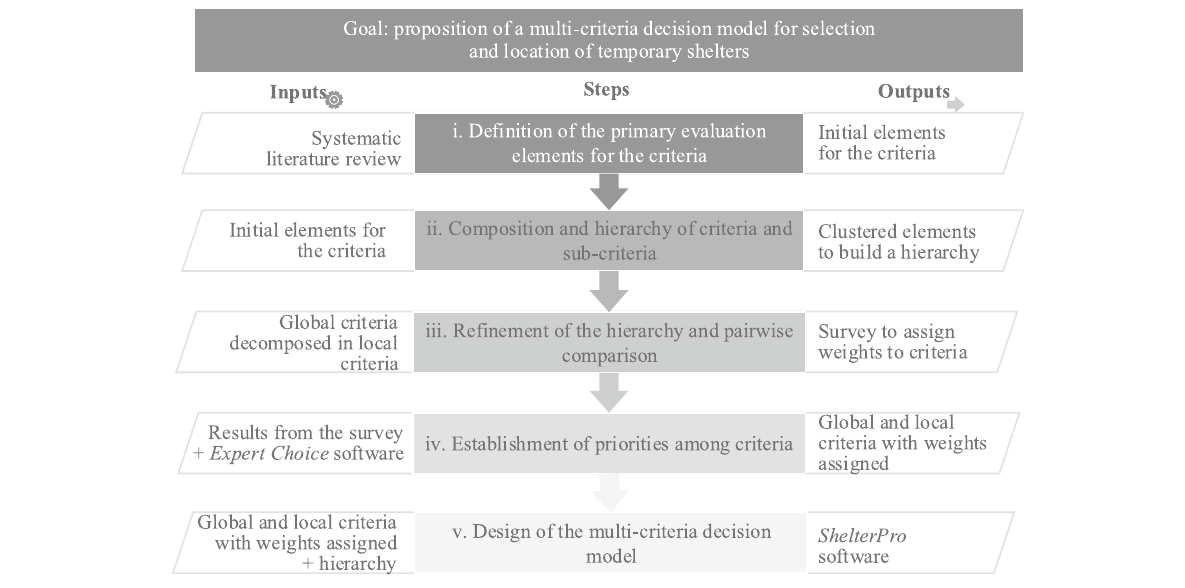
Fig. 1 Methodological steps to develop the multi-criteria decision model